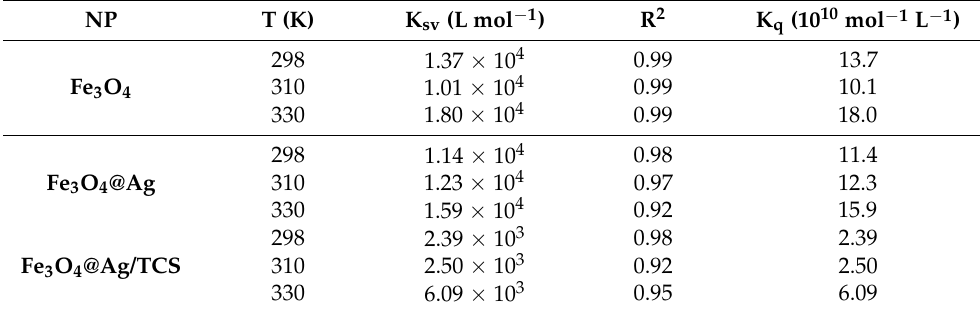
Table 2. Parameters estimated for Fe 3 O 4 NPs, Fe 3 O 4 @Ag NPs, and Fe 3 O 4 @Ag/TCS NPs fitted